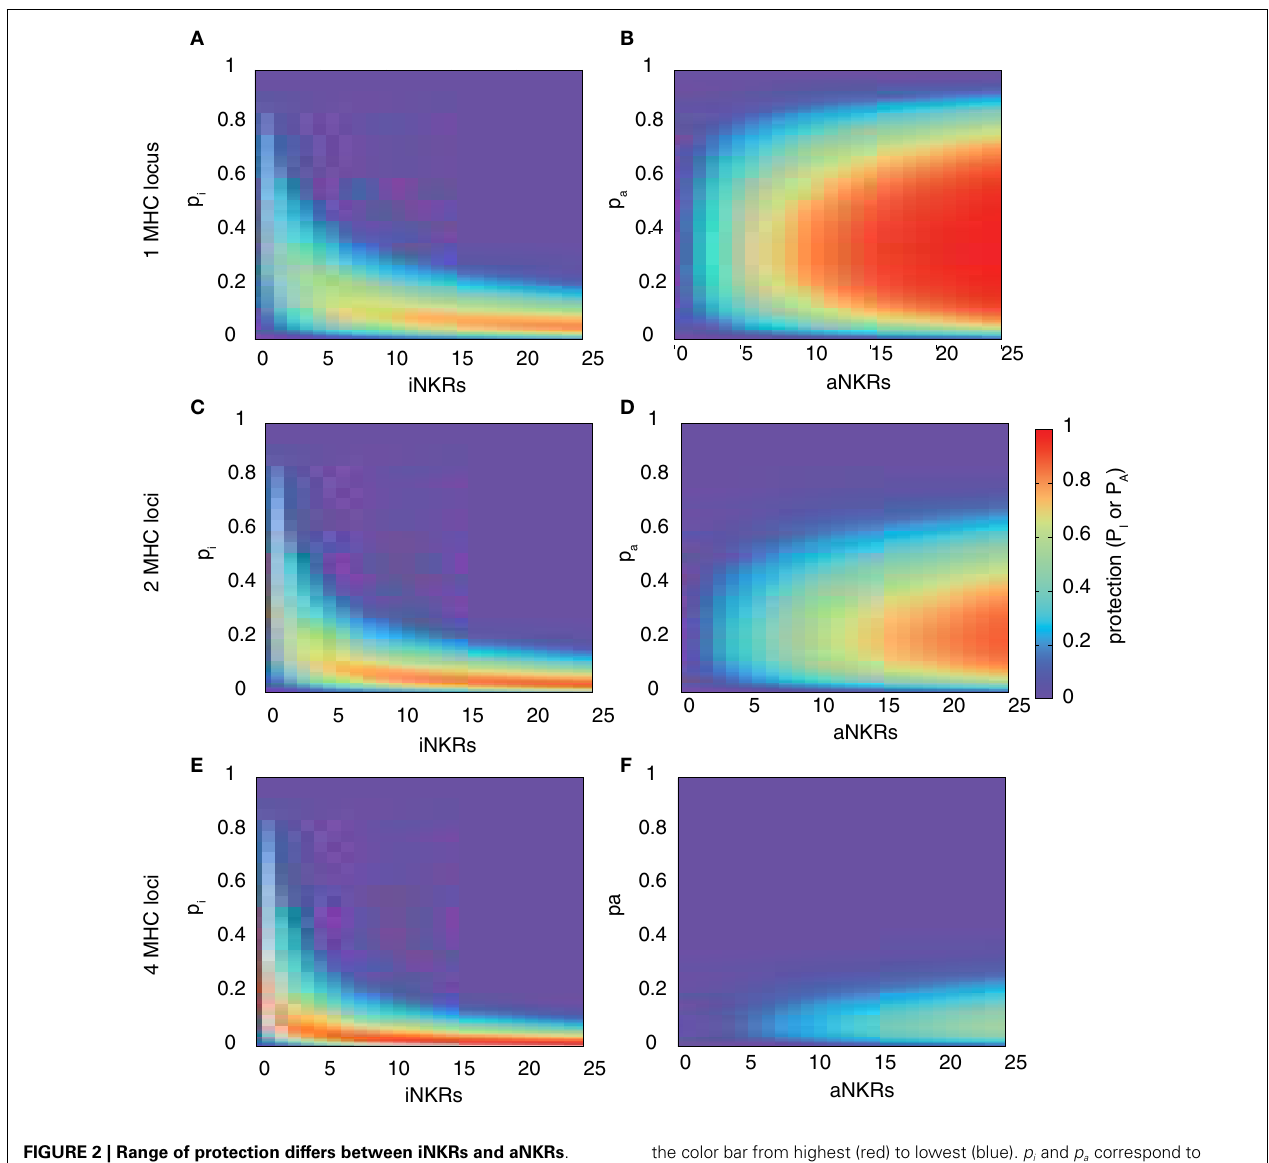
FIGURE 2 | Range of protection differs between iNKRs and aNKRs . The heatmaps show the protection level as the probability of detecting the infection with a virus expressing a decoy molecule to mask MHC down-regulation. In the left column, the protection for individuals carrying only iNKRs [calculated by equation (2)] is shown, whereas in the right column, the protection for individuals carrying only aNKRs [calculated by equation (3)] is depicted.The protection level is shown in